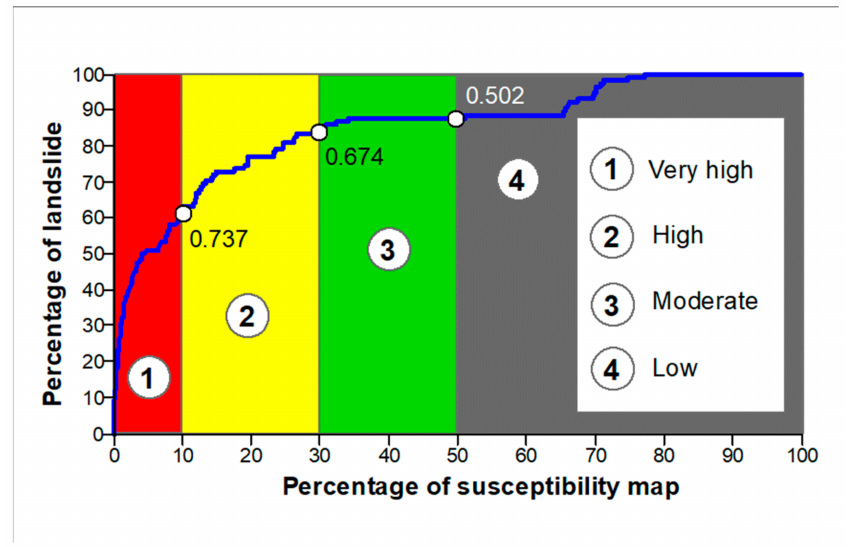
Figure 6. Percentage of landslides vs. percentage of susceptibility map for Than Uyen